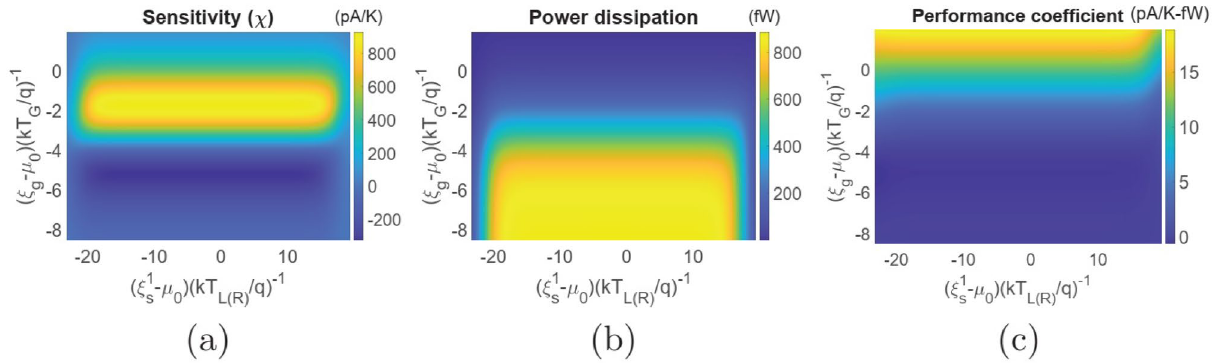
Figure 6. Regime of operation of the proposed triple dot thermometer in terms of the ground state energy positions relative to the equilibrium Fermi energy µ 0 . Colour plot demonstrating the variation in ( a ) sensitivity ( χ ) ( b ) power dissipation and ( c ) performance coefficient with variation in the ground state positions ξ 1 s and ξ g . The parameters used for simulation are U m = 100 µ eV, γ c = 10 µ eV, V = 1.1 mV and T L ( R ) = T G = 300